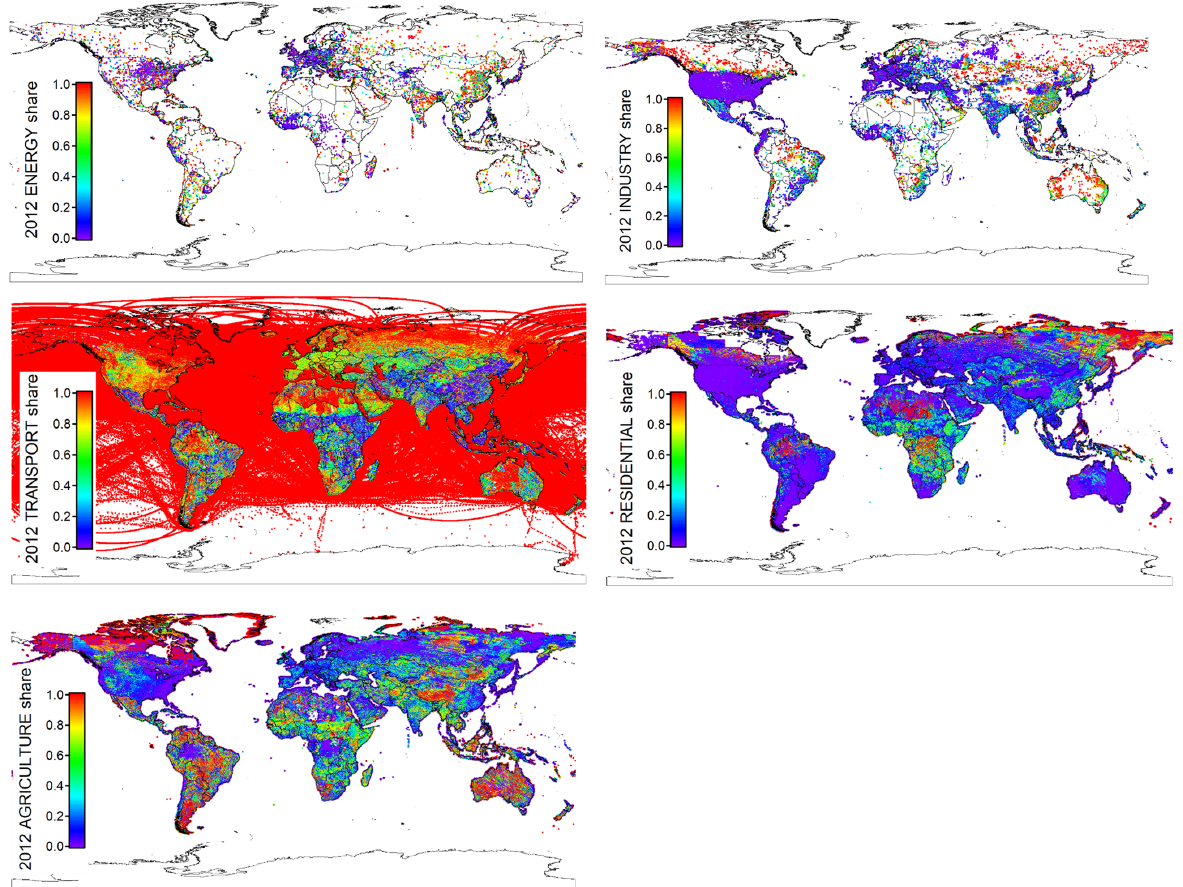
Figure 14. NO x emission sector shares for the year 2012 at the grid-cell